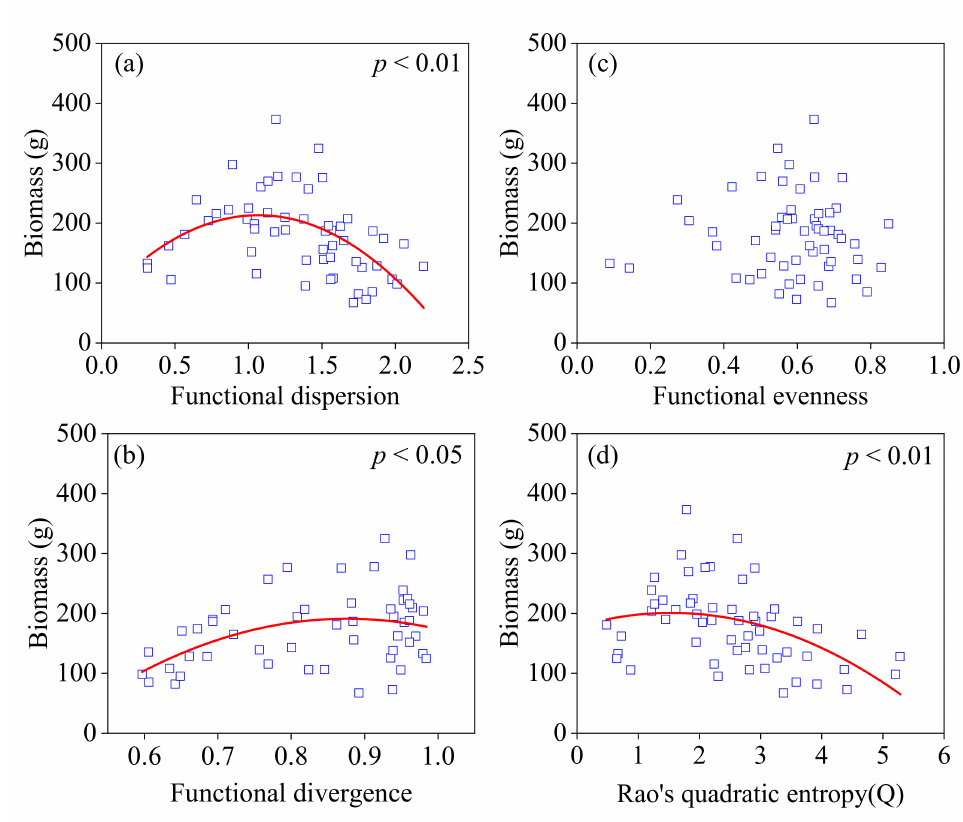
Figure 6. Relationships between aboveground biomass (AGB) and functional diversity metrics ( a – d ).